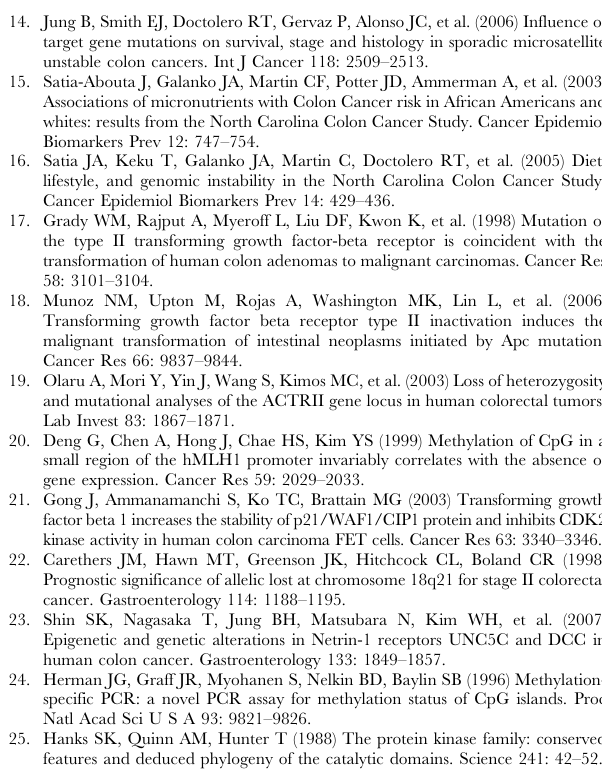
Table S1 Specific primers used in LOH analysis, ACVR2 genotyping as well as ACVR2 promoter bisulfite sequencing. F denotes forward primer, R denotes reverse primer; U denotes unmethylated and M